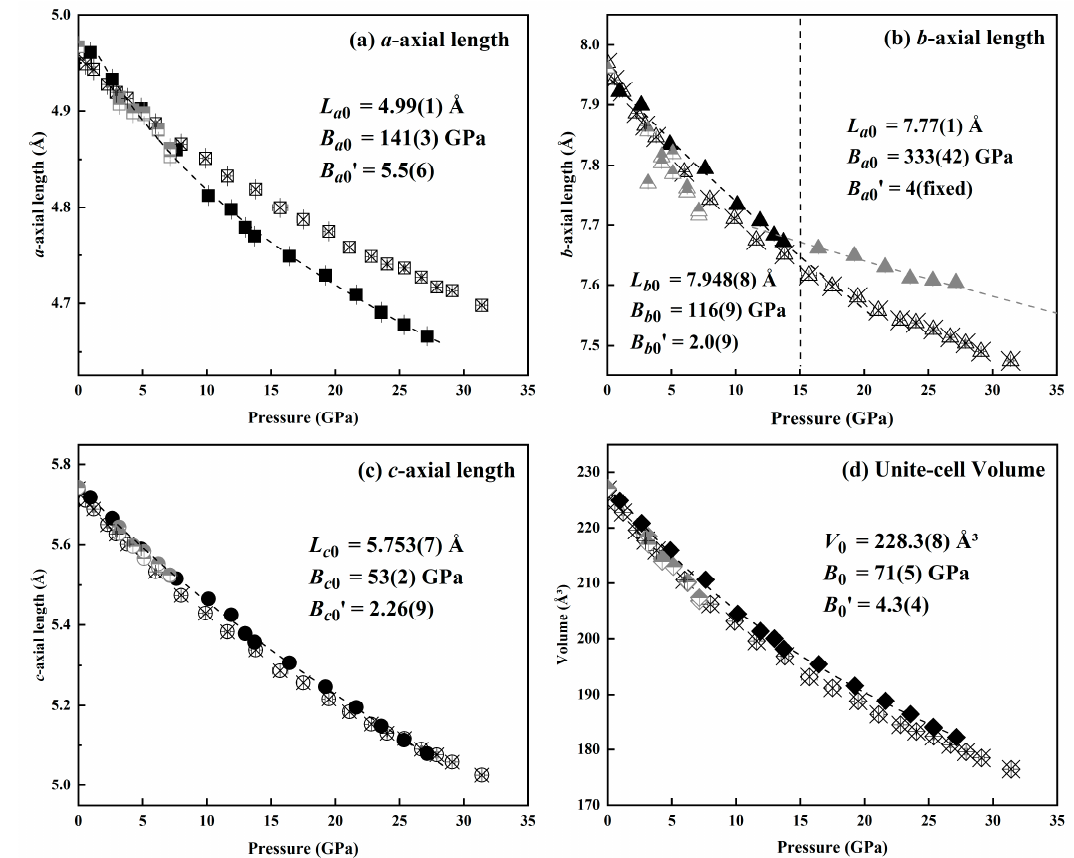
Figure 2. Lattice parameters of aragonite derived from X-ray diffraction (XRD) patterns upon pressure. The uncertainty in the value is generally smaller than the symbol size. The dashed black curve represents the fit of the data to the third-order Birch–Murnaghan equation of state (BM EoS). The XRD data referred from Palaich et al. [33] (symbols with a cross in the center) and from Martinez et al. [36] (half-closed symbols) are plotted for comparison. Table 1. Aragonite unit-cell parameters and volume up to 27.1 GPa.